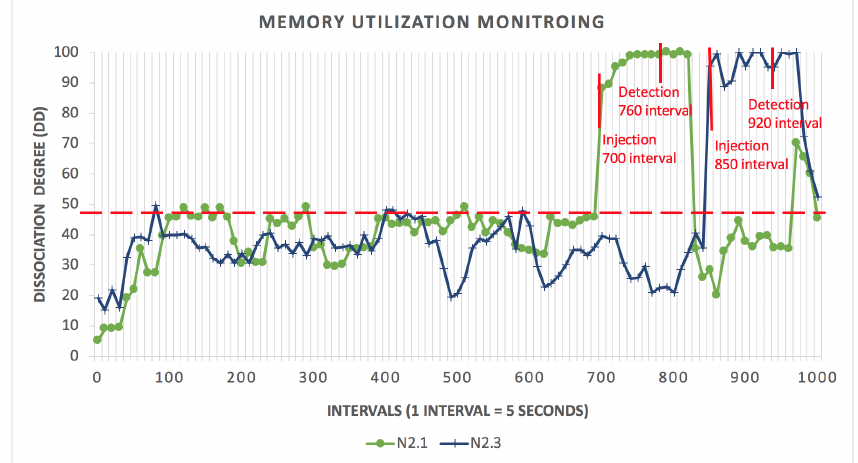
Figure 4. Memory leak detection using HHMM for the whole